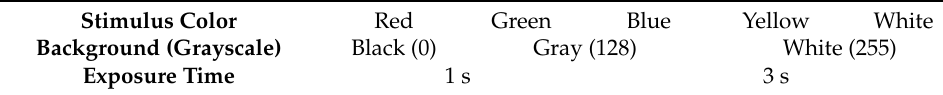
Figure 2. An example of the viewing field. Table 1. Parameters of the afterimage experiment.